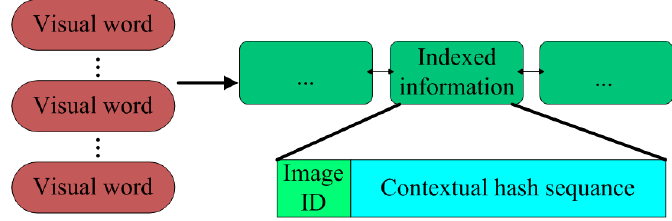
Figure 6. The structure of the inverted index file.